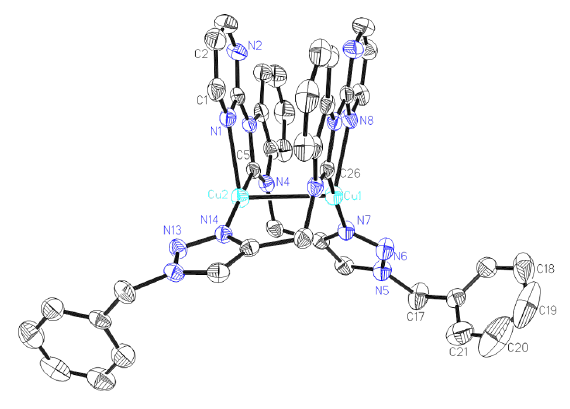
Figure 2: ORTEP the cationic section of [Cu 2 (L 2 ) 2 ](PF 6 ) 2 ( 3 ). Thermal ellipsoids are drawn at the 30% probability level. Hydrogen atoms and anions have been removed for clarity. Selected bond distances (Å) and angles (°): Cu2-C5 1.896(3), Cu2-N14 1.911(3), Cu2-N1 2.362(3), Cu2-Cu1 2.7867(7), Cu1-C26 1.898(3), Cu1-N7 1.915(3), Cu1-N8 2.340(3); C5-Cu2-N14 173.37(13), C5-Cu2-N1 77.64(13), N14-Cu2-N1 108.15(12), C5-Cu2-Cu1 69.80(9), N14-Cu2-Cu1 111.70(8), N1-Cu2- Cu1 98.90(7), C26-Cu1-N7 167.08(15), C26-Cu1-N8 78.22(13), N7-Cu1-N8 111.77(13), C26-Cu1-Cu2